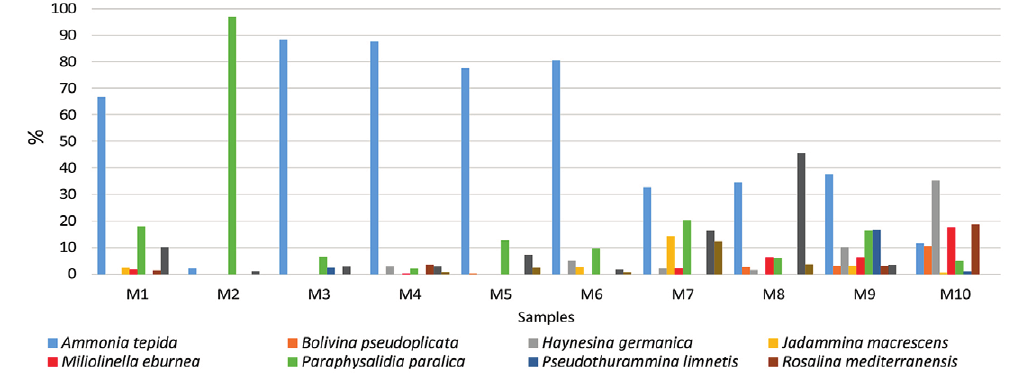
Fig. 3. – A. Stratigraphic column of the S-8 core. Textural distribution (%), organic matter (%) and CaCO terpretation is also shown for each chronostratigraphic unit. B. Index diversity of the foraminifera of the S-8 core. Shannon-Wiener, Margalef richness, Equitability and Fisher’s alpha. A palaeoenvironmental interpretation is also shown for each chronostratigraphic